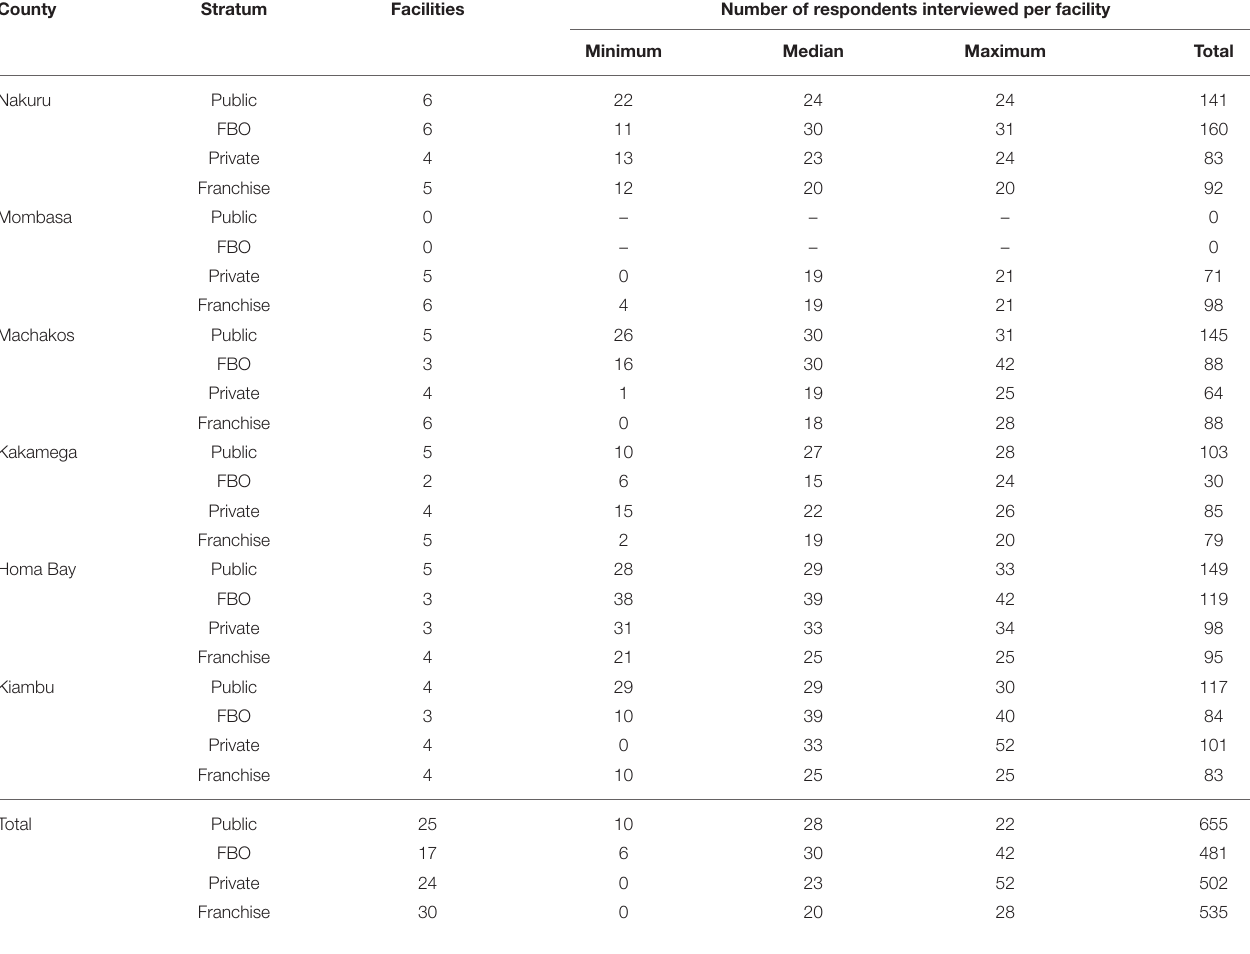
TABLE 1 | Distribution of facilities by county and